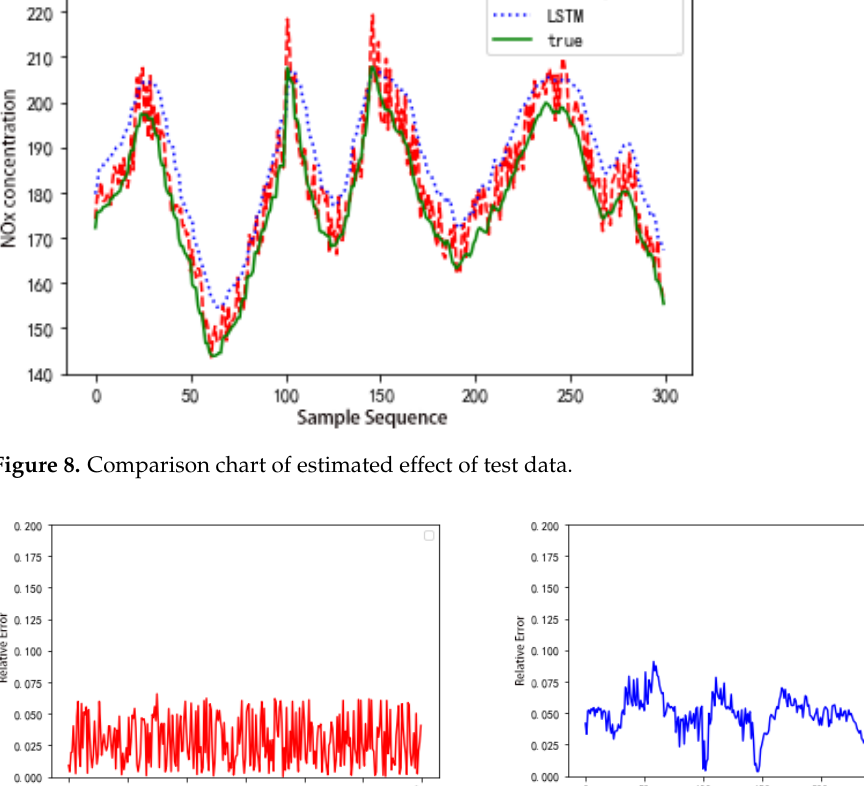
Figure 7. ( a ) Training-data estimation error. ( b ) Training-data estimation error.